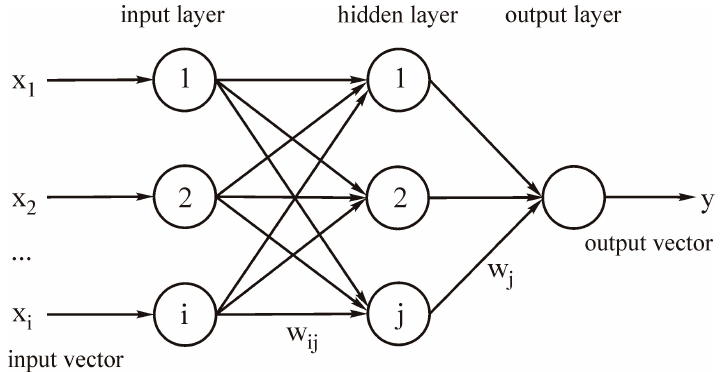
Figure 4. The structure of the multi-layer perceptron artificial neural networks (ANN) model used for the study.